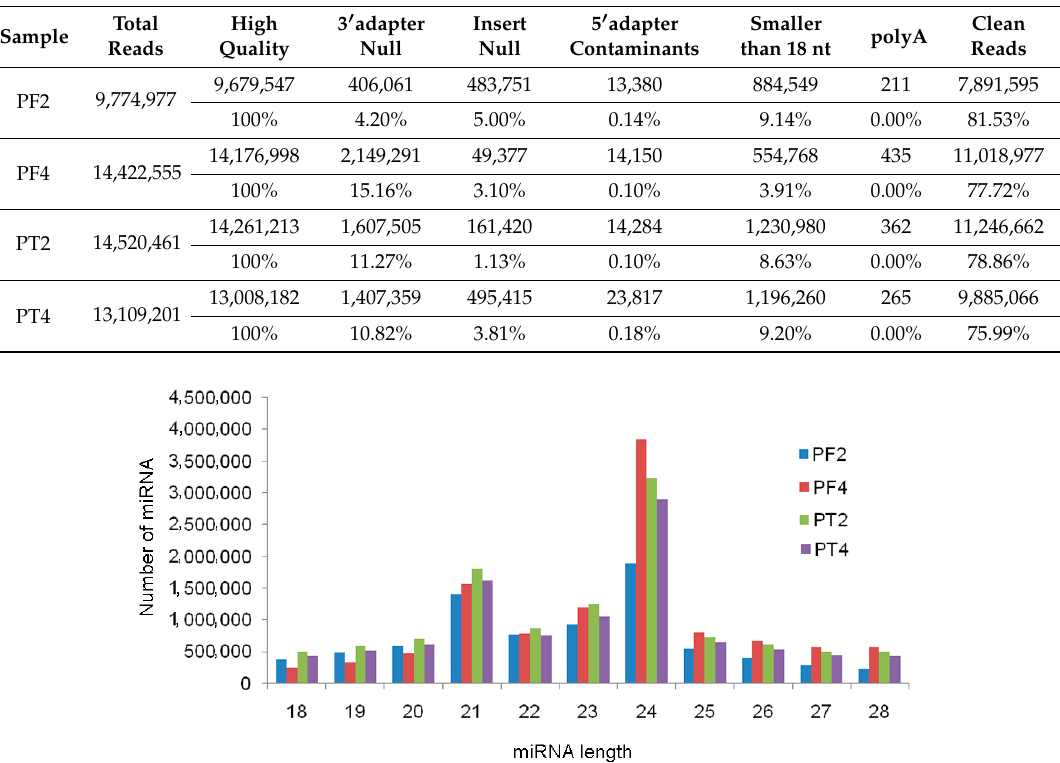
Figure 2. Correlation coefficients of the gene expression of duplicate samples. X-axis represents the logarithmic value of diploid P. tomentosa (PT2) expression, while Y-axis represents the logarithmic value of the corresponding duplicate samples.